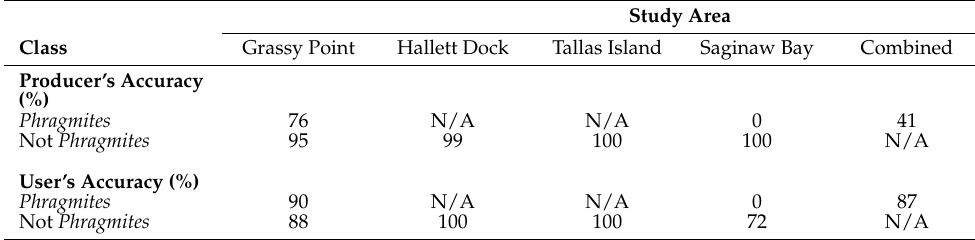
Table 12. Classification performance for all four study sites when using RGB UAS imagery, UAS- derived CHM, and RADARSAT-2 HH polarization. Producer’s accuracy and user’s accuracy are provided for each study site. Only the accuracy of the Not Phragmites class was calculated for Hallett Dock and Tallas Island. The combined accuracy of the Not Phragmites class was not calculated. Study Area Grassy Point Hallett Dock Tallas Island Saginaw